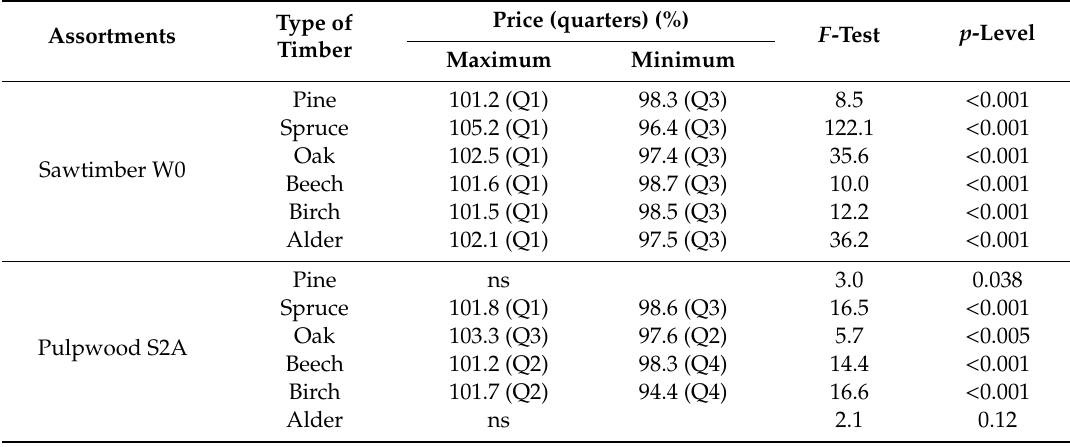
Table 2. Seasonal fluctuations in the prices of sawtimber (W0) and pulpwood (S2A).